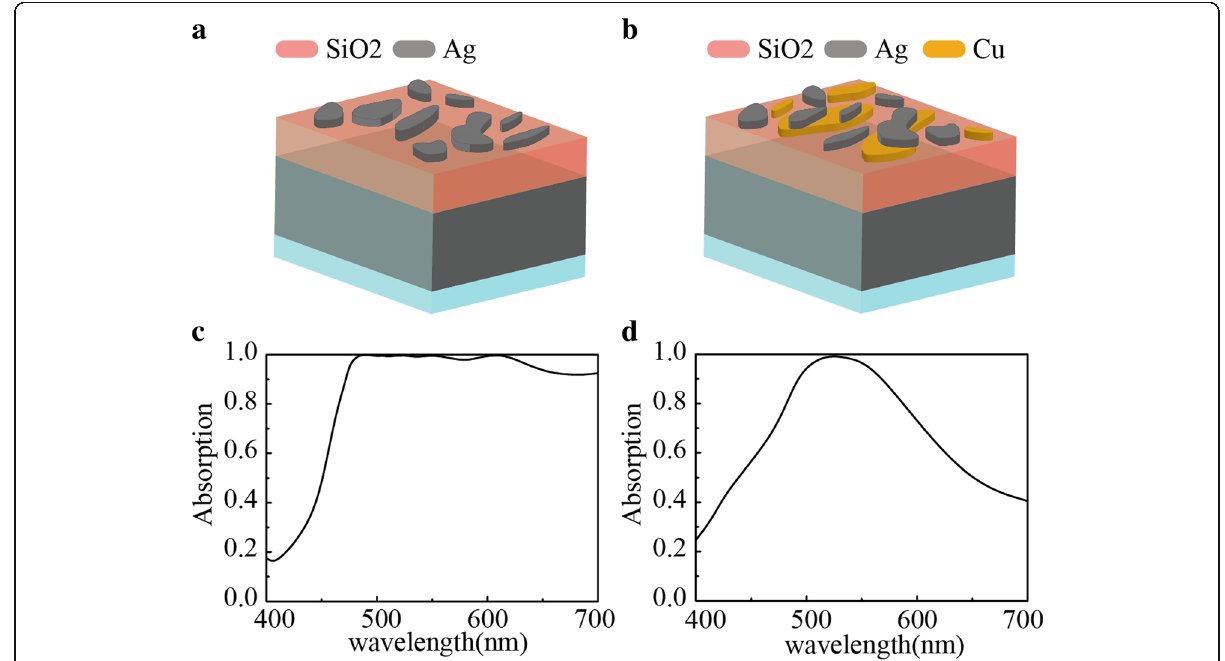
Fig. 2 Schematics of the absorbers and simulated absorption spectra of the Ag NP and Ag-Cu NP absorbers. In these two absorbers, the carrier is glass and the underlying metal and dielectric layers are silver and silicon dioxide. c and d respectively show the absorption spectra of Ag NP absorber and Ag-Cu NP absorber structure